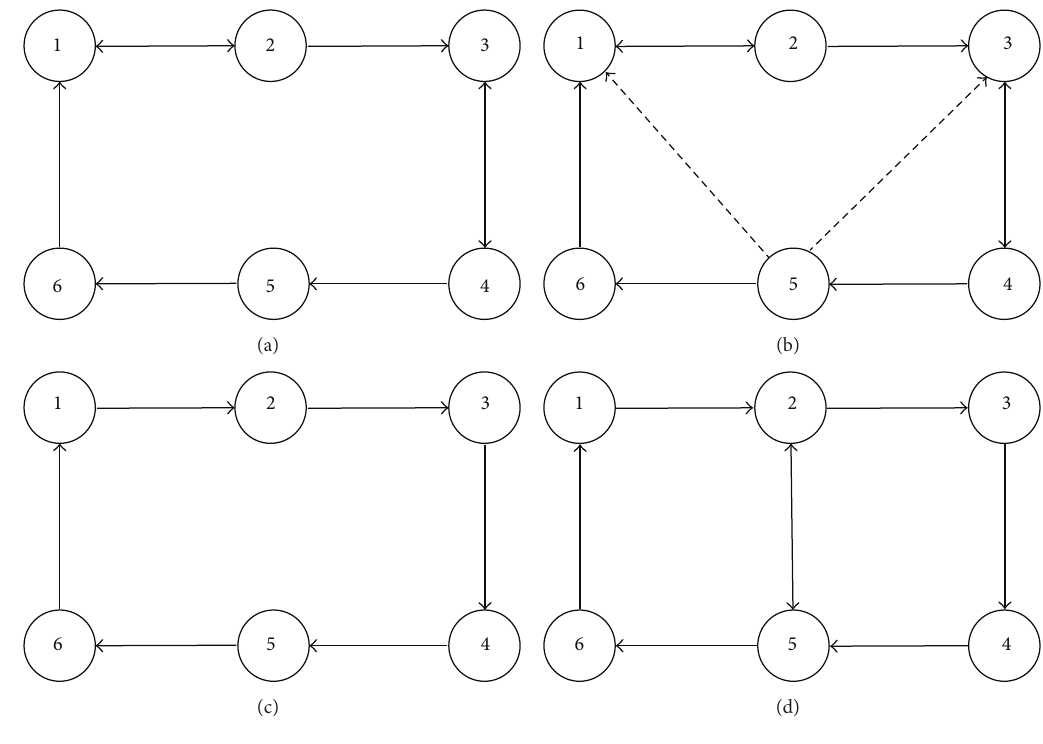
Figure 1: Four digraphs: (a) G 𝑎 , (b) G 𝑏 , (c) G 𝑐 , and (d) G 𝑑